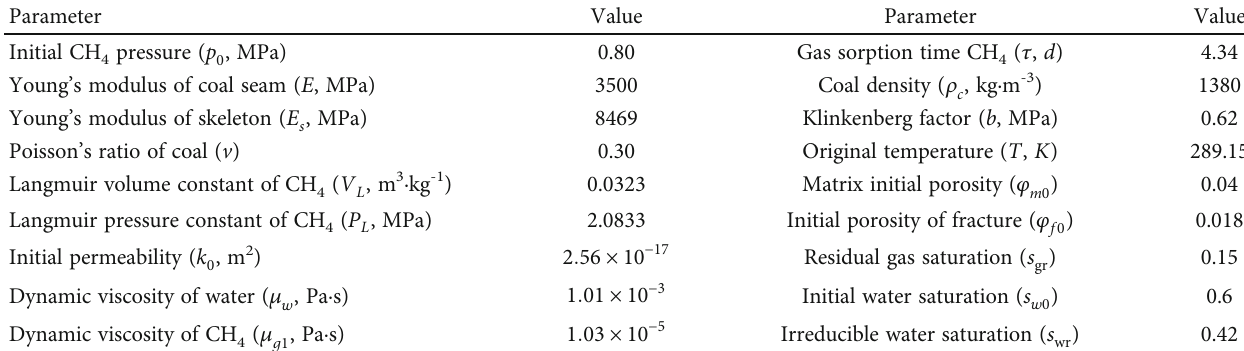
Table 1: Numerical simulation parameters.